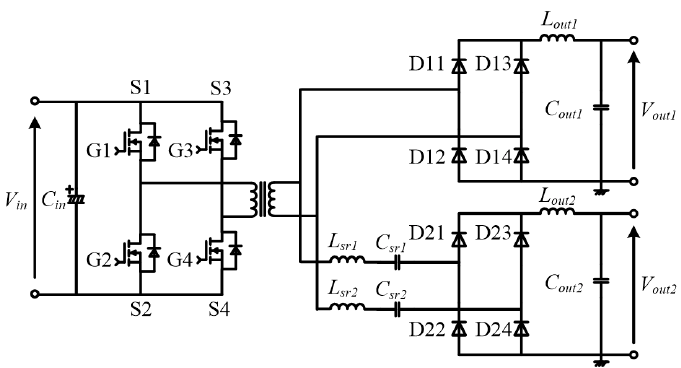
Figure 2. Circuit configuration for applying proposed control method.